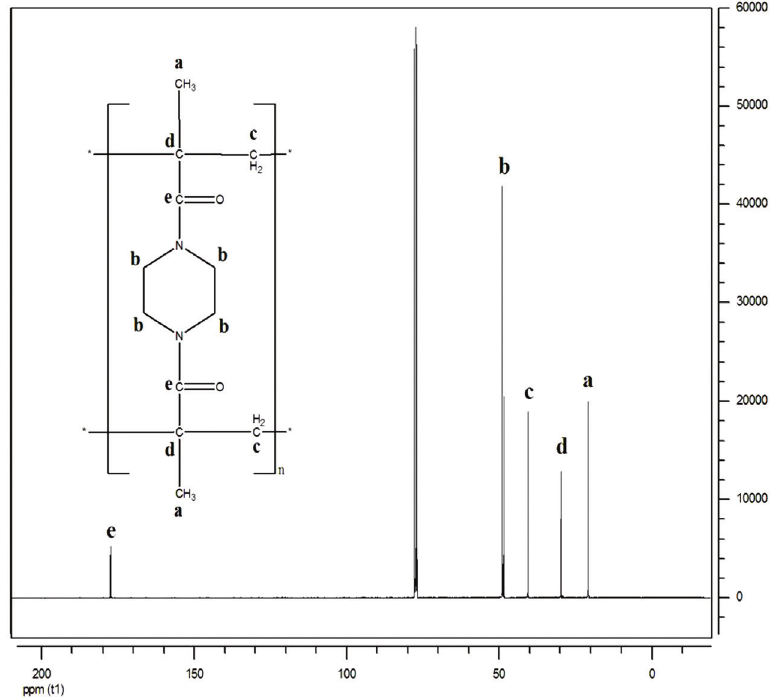
Figure 10: 13 C NMR spectrum (CDCl